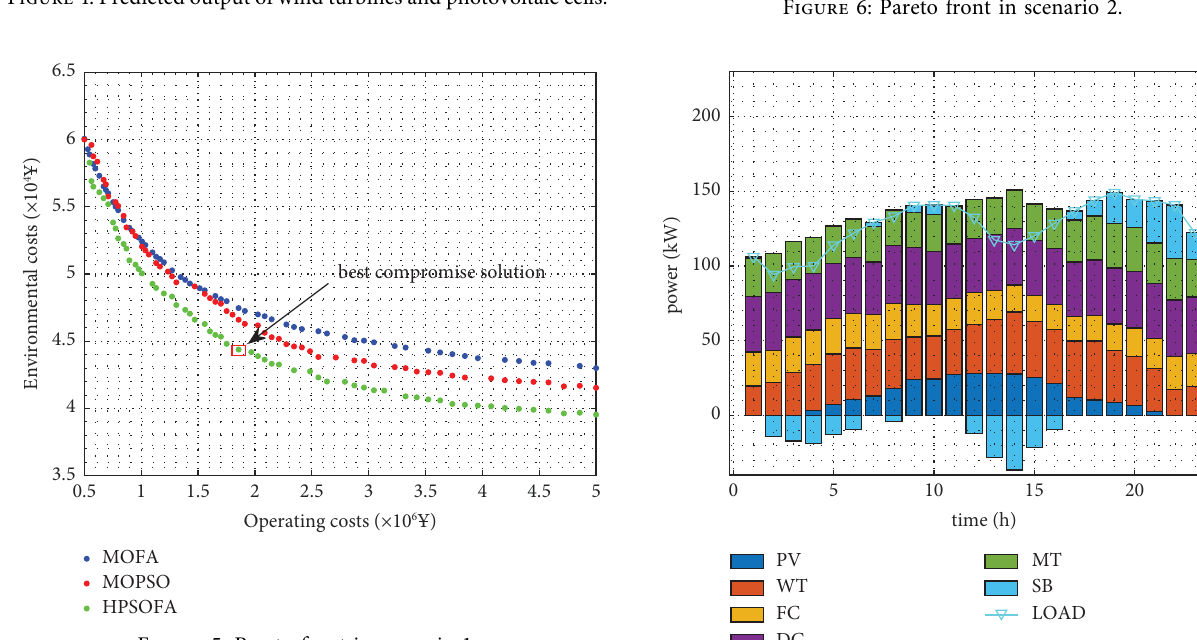
Figure 7: Optimal day-ahead scheduling in scenario